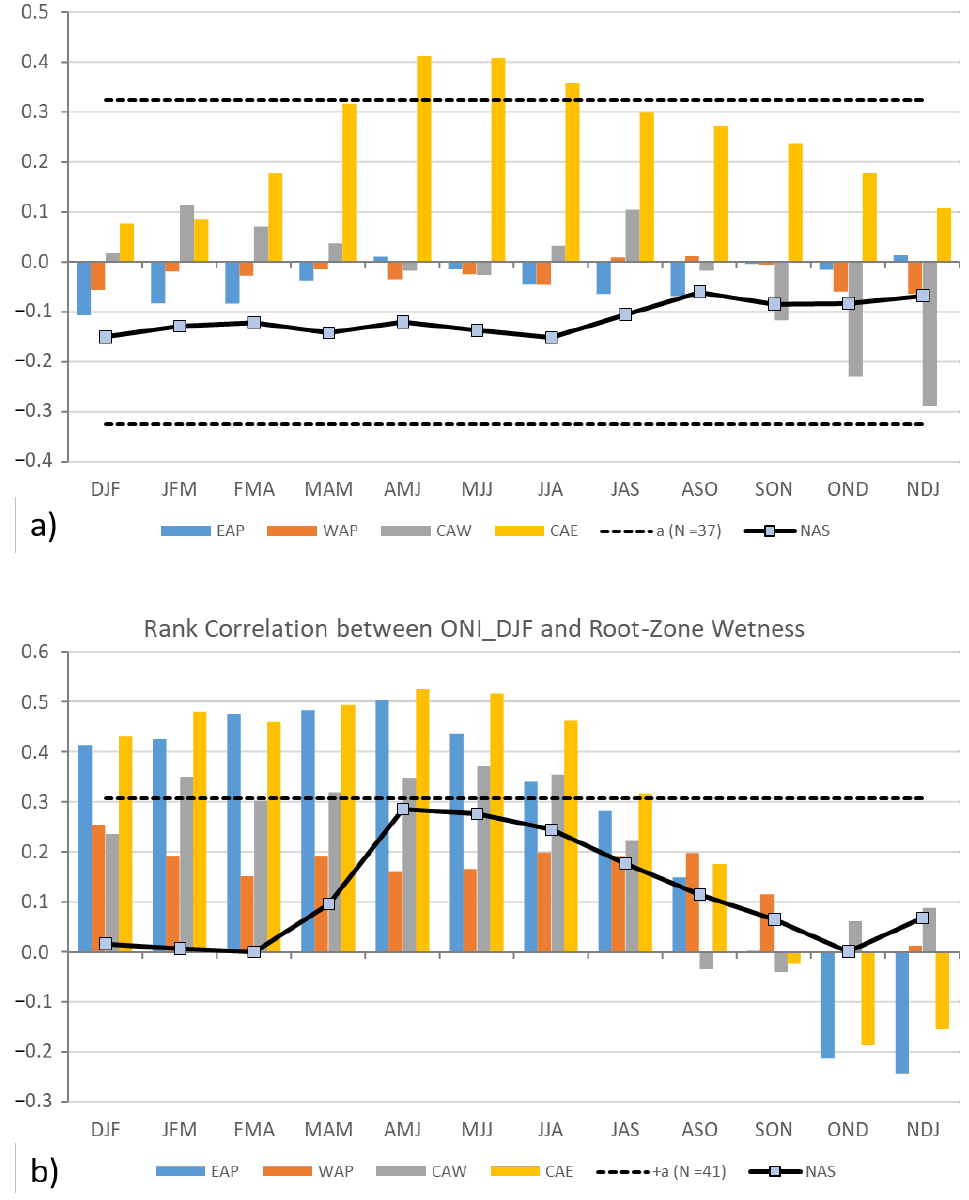
Figure 9. Same as Figure 7, but for the mean 3-month NDVI values with critical rho = 0.3247 for N = 37 during 1981–2019 ( a ) and MERRA-2 root-zone wetness with critical rho = 0.3082 for N = 41 during 1980–2021 ( b ).